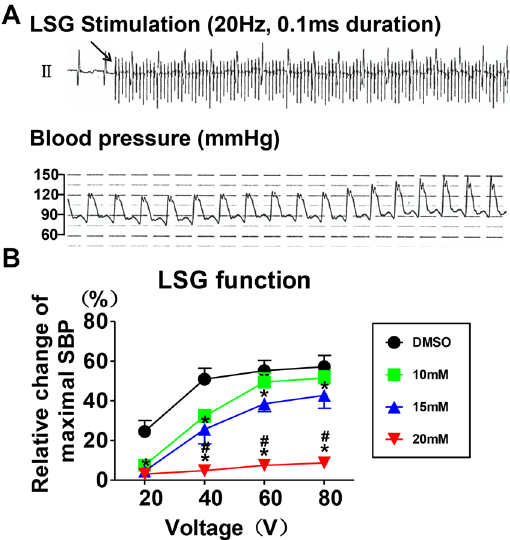
Figure 4. Effects of Nav1.8 channel block on LSG function. ( A ) The representative BP elevation example in response to LSG electrical stimulation. ( B ) The voltage/BP response curve in different groups. Blocking Nav1.8 channel attenuated LSG function. * p < 0.05 vs DMSO group, # p < 0.05 vs 10 mM group. SBP = systolic blood pressure.